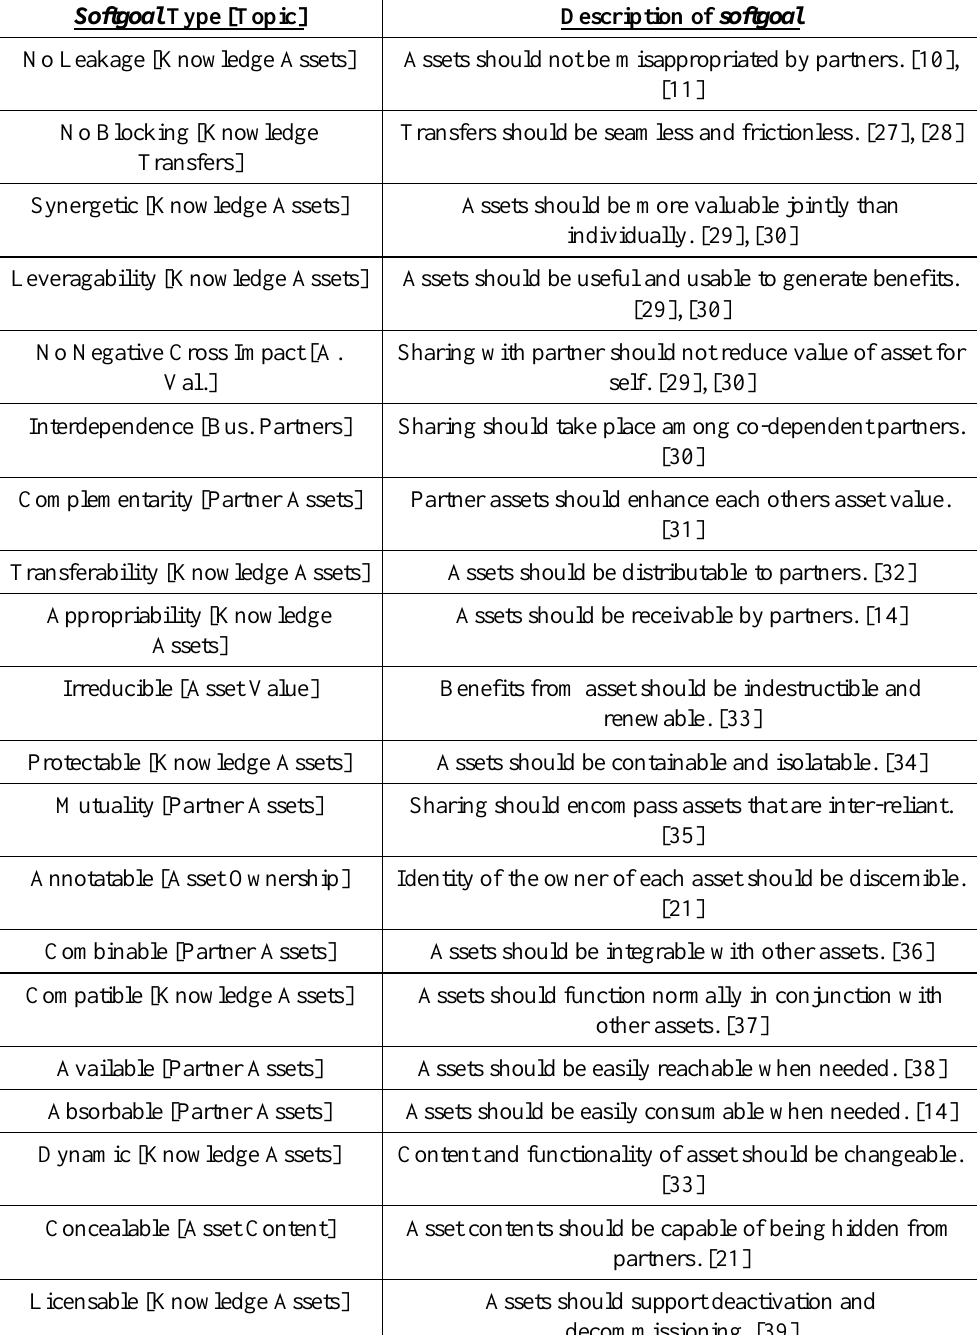
Table 1. Softgoal types and topics in As-Is scenario in Figure